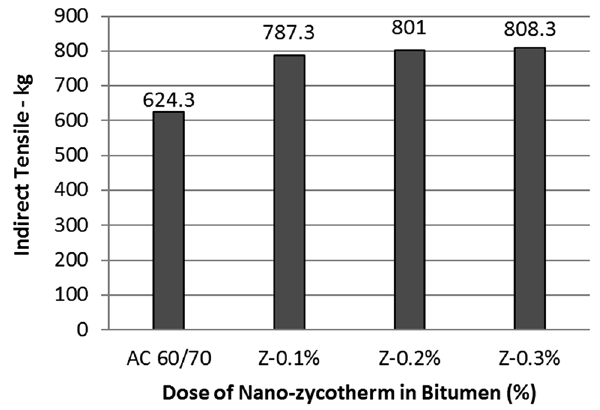
Fig. 6 Indirect Tensile Strength (ITS) of all mixes under dry condi- tion